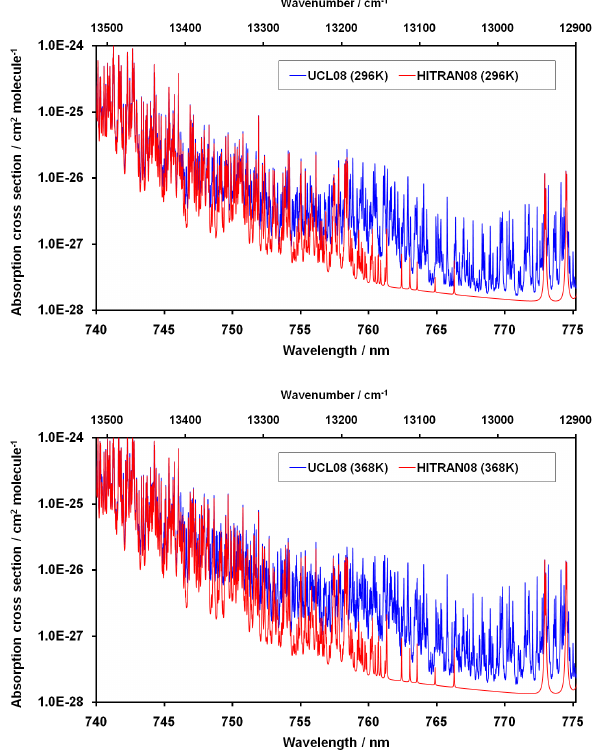
Fig. 4. Upper panel: The ratio of line strengths for water monomer Fig. 3: Comparisons of water monomer absorption cross sections on the low frequency side of the lines common to the HITRAN08 and UCL08 lists. The heavy Fig. 3. Comparisons of water monomer absorption cross sections horizontal lines indicate the intensity-weighted average of the 720 nm water band in the region of the red-shifted the 040 OH b stretching overtone. Cross on the low frequency side of the 720nm water band in the region bf (cid:12) line strength ratios in the spectral regions 6000–8000cm − 1 (av- of the dimer’s red-shifted (cid:12) 0 i f | 4 i b | 0 i OH b stretching overtone. sections from the HITRAN08 (Rothman et al., 2009; red) and UCL08 line lists (this work; blue) are erage=1.0198), 8000–9500cm − 1 (1.216) and 9500–11000cm − 1 Cross sections from the HITRAN08 (Rothman et al., 2009; red) and shown for 296 K and 386 K in the upper and lower panels respectively. (1.025). Lower panel: ratio of UCL08/HITRAN08 intensities as UCL08 line lists (this work; blue) are shown for 296K and 386K - 29 - a function of line strength for lines between 8000 and 9500cm − 1 . in the upper and lower panels respectively. The strong lines, which necessarily dominate the intensity-weighted average, typically have ratios around 1.2. The majority of the weaker lines also show intensity ratios between 1.0 and 1.2, sug- gesting the difference is